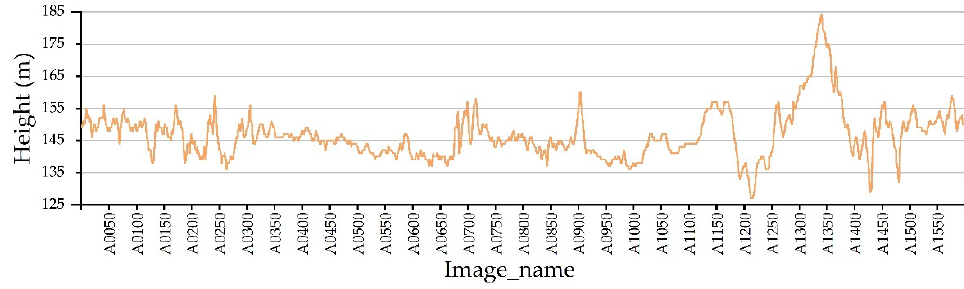
Figure 7. Example of the height component of the raw Global Navigation Satellite System (GNSS) data.